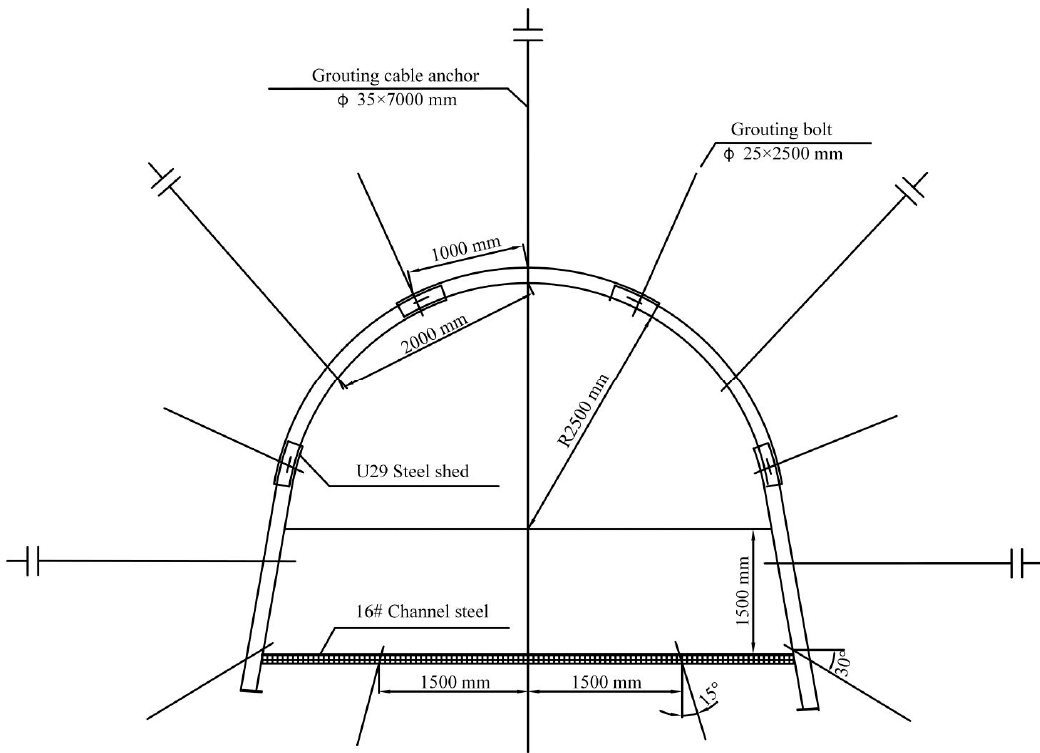
Figure 12. Roadway full-section support